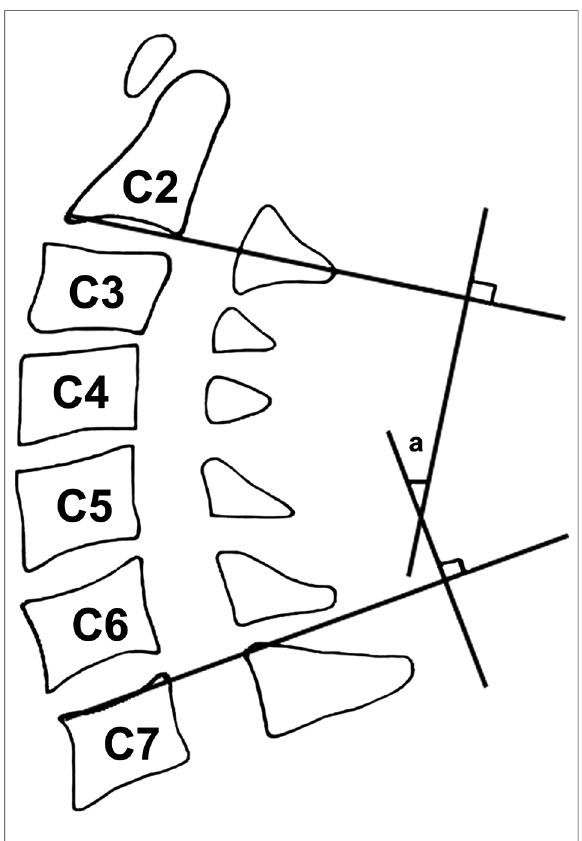
FIGURE 2 Cobb angle for measuring cervical lordosis. Cobb angle is measured on lateral x-ray of the lumbar spine: the angle (a) is formed by the inferior endplate of the C2 to the inferior endplate of the